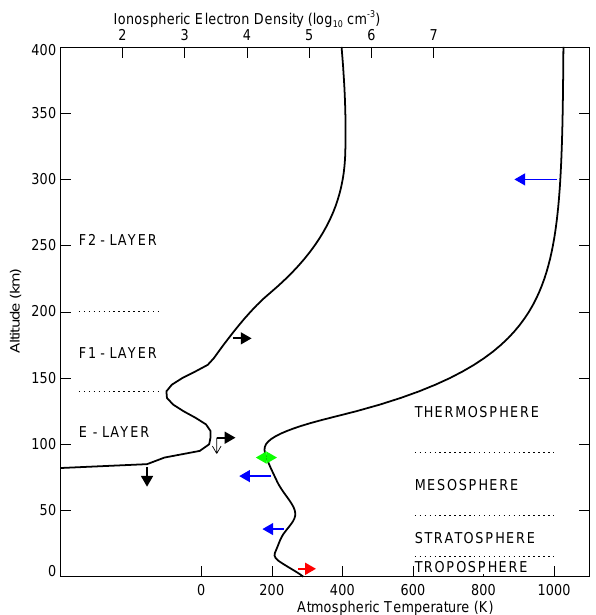
Fig. 5. Trends in Earth’s atmosphere. The atmospheric layers are defined by the temperature profile. The ionospheric layers are de- fined by the electron density profile (midnight at equator). Arrows indicate the direction of change. Red – warming; blue – cooling; green – no change of temperature; black – changes in electron den- sity (horizontal) and heights of ionospheric layers